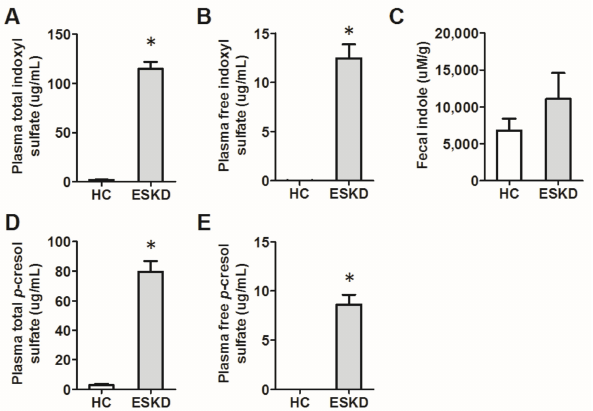
Figure 3. The plasma levels of indoxyl sulfate and p -cresol sulfate of end-stage kidney disease (ESKD) patients are significantly higher than healthy controls (HC) (panels ( A , B , D , E )). The fecal level of a microbial metabolite, indole, tends to be higher in ESKD patients, but the difference did not achieve statistical significance (panel ( C )). * p < 0.05.